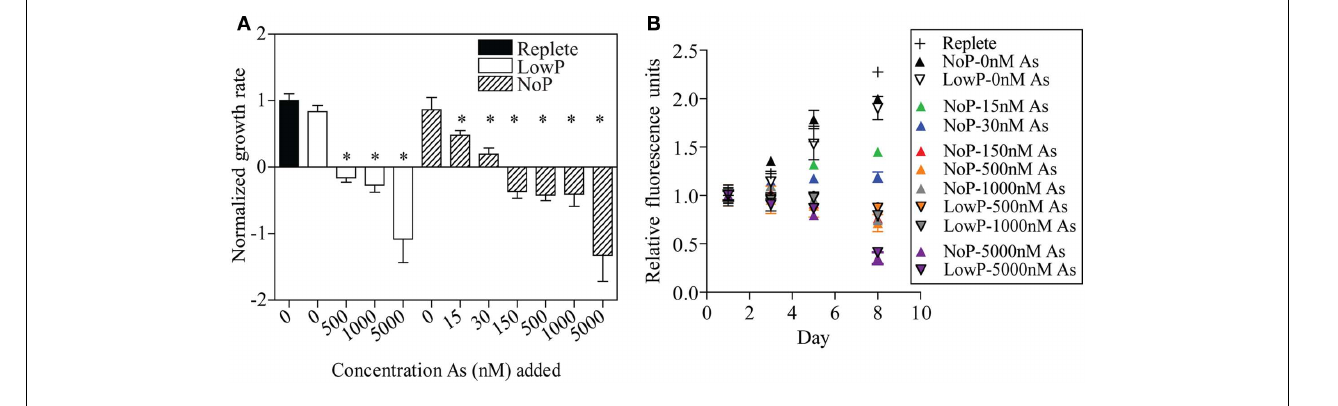
growth rates from the Replete control ( p < 0.05) are indicated (*) for each treatment using a 1-way ANOVA. (B) C. watsonii WH8501 relative fluorescence as a function of day in growth curves for each P and as treatment.Treatment key is ordered by the yield on day 8. Error bars are the SE of the mean ( n =